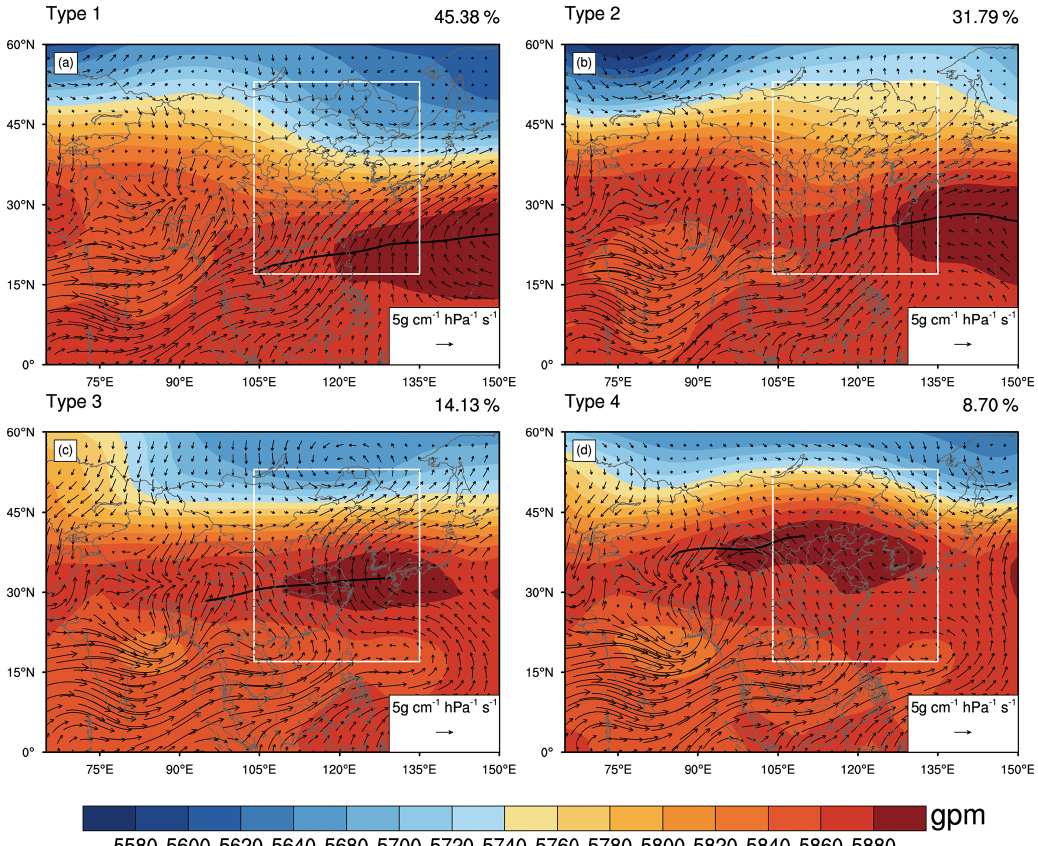
Figure 4. 850hPa water vapor flux (WVF = V · q/g , where q is specific humidity, g is gravitational acceleration and V is horizonal wind; vectors indicate WVF; see scale arrow in the bottom right in units of 5gcm − 1 hPa − 1 s − 1 ) and 500hPa GH (contours indicate GH; see scale bar at bottom in units of gpm) patterns based on objective classification (see text for details). The white framed area is the area of eastern China, the number in the upper-right corner of each panel indicates the frequency of occurrence of each pattern type and the black line in each panel presents the ridge axis of the